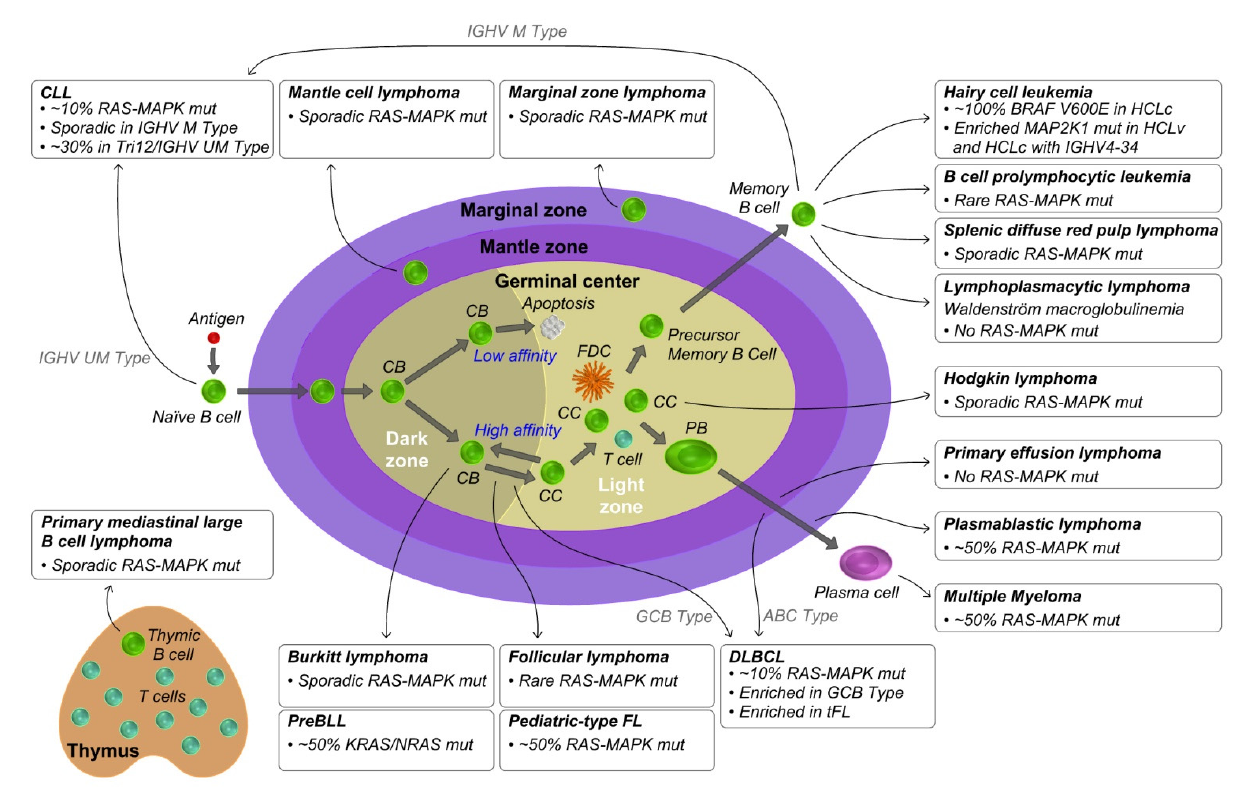
Figure 2. Origin of mature B cell lymphoproliferative disorders and RAS-MAPK pathway deregu- lation. In the T cell-dependent immune response, the encounter of naïve B cells with the cognate antigens promotes their activation and the formation of germinal centers (GC). In the GC, B cells undergo B cell receptor (BCR) editing through somatic hypermutation (SHM) and class-switch re- combination (CSR) to generate B cells with high affinity antibodies of different isotype classes. B cells will differentiate in memory B cells and long-lived plasma cells. In the GC, B cell cycles several times between the dark zone, where proliferation and SHM occur, and the light zone, where interaction with follicular dendritic cells and T cells allow B cell activation and selection on the basis of affinity of their BCR. Acquisition of genetic lesions disrupts normal B cells development and differentia- tion, leading to malignant transformation. Each mature B cell malignancy is reminiscent of B cells at a particular stage of differentiation, defined as the normal B cell counterpart. The reviewed B cell neoplasms are depicted at the site of their normal counterpart, and incidence of RAS-MAPK aberrations is shown. CB, centroblast; CC, centrocyte; FDC, follicular dendritic cell; PB, plasmablast; mut, mutations; CLL, chronic lymphocytic leukemia; IGHV, immunoglobulin heavy-chain variable region gene; M, mutated; UM, unmutated; Tri12, trisomy 12; HCLc, classic hairy cell leukemia; HCLv, variant hairy cell leukemia; DLBCL, diffuse large B cell lymphoma; GCB, germinal center B cell-like; ABC, activated B cell-like; FL, follicular lymphoma; tFL, DLBCL transformed from follicular lymphoma; PreBLL, precursor B cell phenotype Burkitt